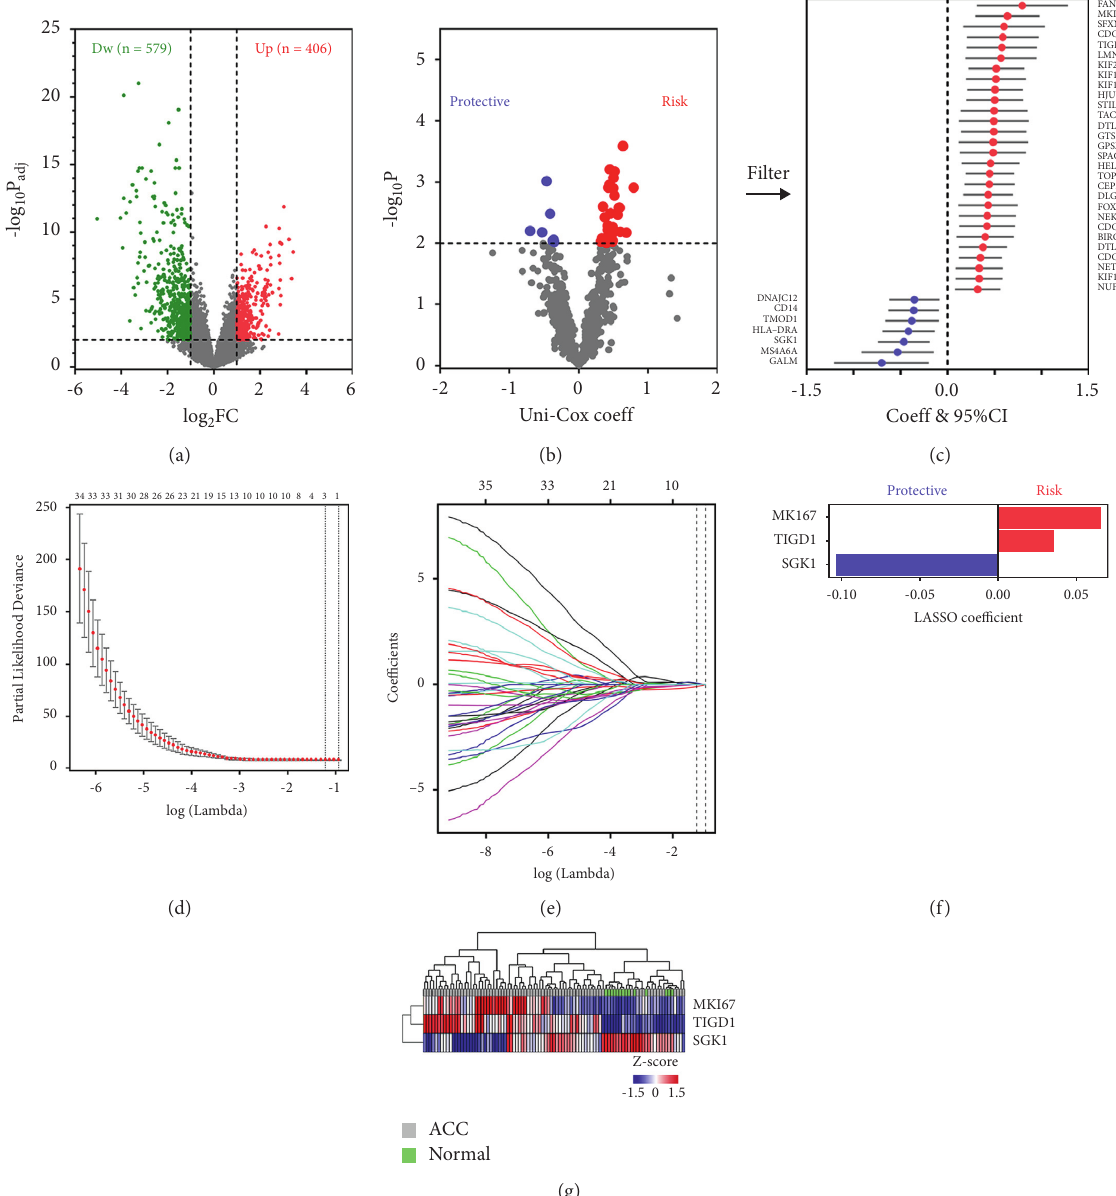
Figure 1: Selection of robust biomarkers to establish a survival-related gene signature: (a) a total of 985 DEGs were identified in ACC compared to normal tissues; (b and c) 35 promising candidates were filtered out using univariate Cox regression analysis; (d) cross- validation was applied to prevent overfitting, and the optimal λ value of 0.2967 with log( λ ) � − 1.215 was selected; (e) MKI67, TIGD1, and SGK1 finally remained with their nonzero LASSO coefficients; (f) distribution of LASSO coefficients of the gene signature; and (g) hi- erarchical clustering analysis showed normal tissues were characterized by lower expression levels of MKI67 and TIGD1 and by higher SGK1 expression levels compared to